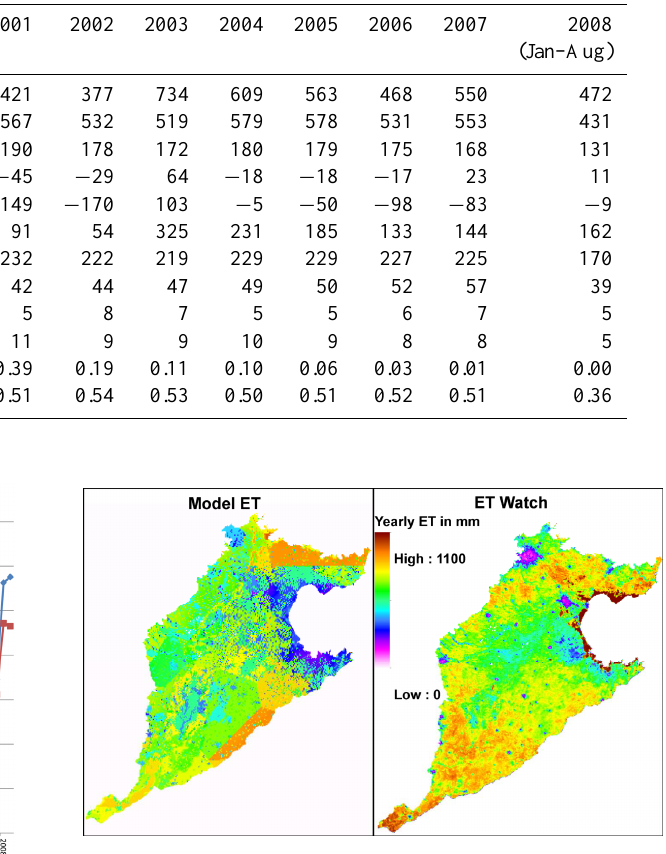
Table 8. Annual water balance components (in unit mm) of the simulation period 2000–2008. ET: evapotranspiration; UZ: unsaturated zone; SZ: saturated zone.